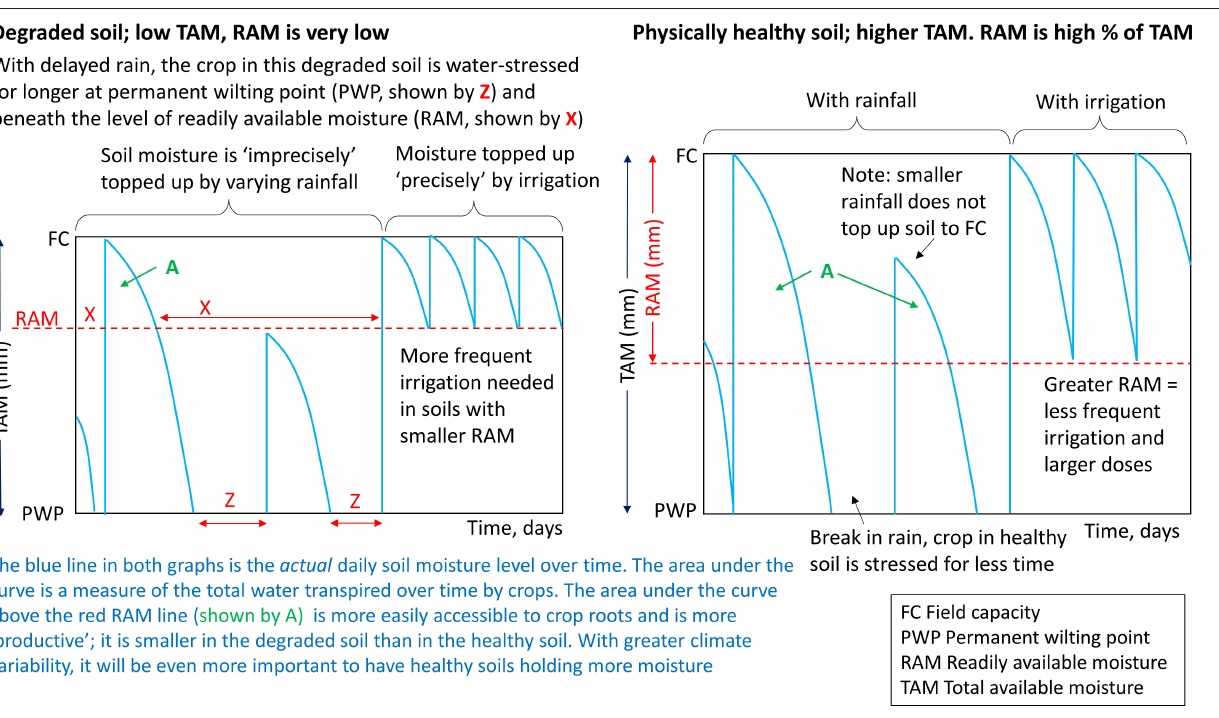
FIGURE 2 | TAM and RAM changing over time in two soil